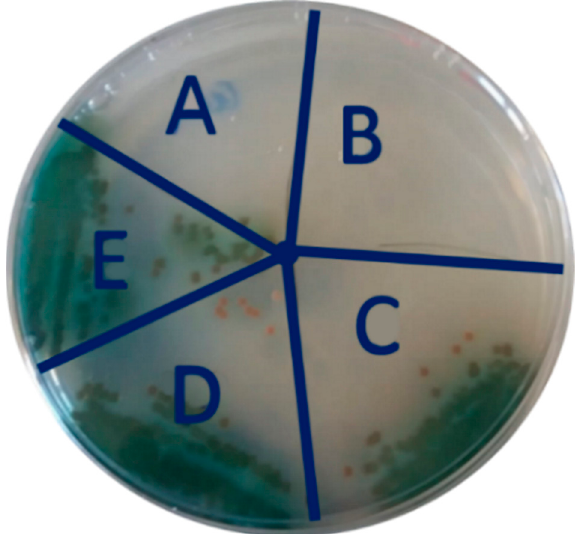
Figure 4. Growth test of P. aeruginosa at 20 days of incubation with s-PBC@PP ( A , B ), PP ( C ), Teflon ( D ), and glass ( E ) samples.